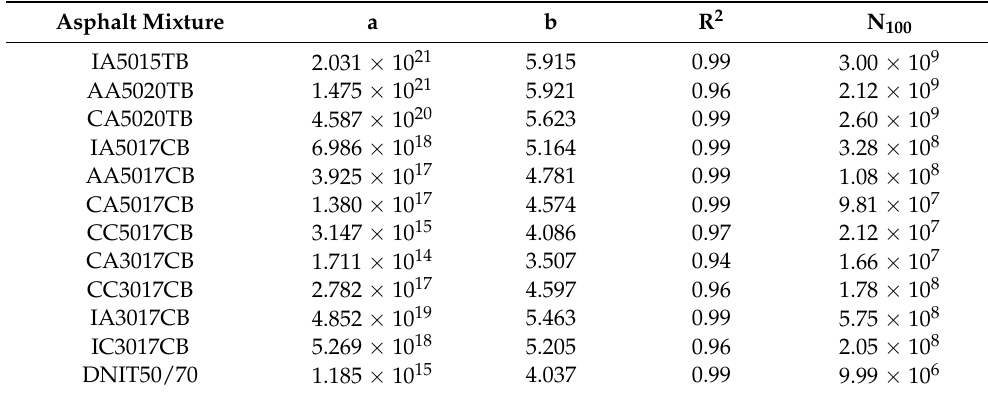
Figure 7. Influence of aggregate gradation ( a ) and asphalt content ( b ) on fatigue resistance. According to Figure 7a, the dense (AI) and gap (Caltrans and ADOT) gradations pre- sented similar fatigue resistances when other parameters were fixed (see CA5017CB vs. AA5017CB; CC3017CB vs. IC3017CB; AA5020TB vs. CA5020TB), but there were also some differences (see CA3017CB vs. IA3017CB; AA5017CB vs. IA5017CB). This means that the